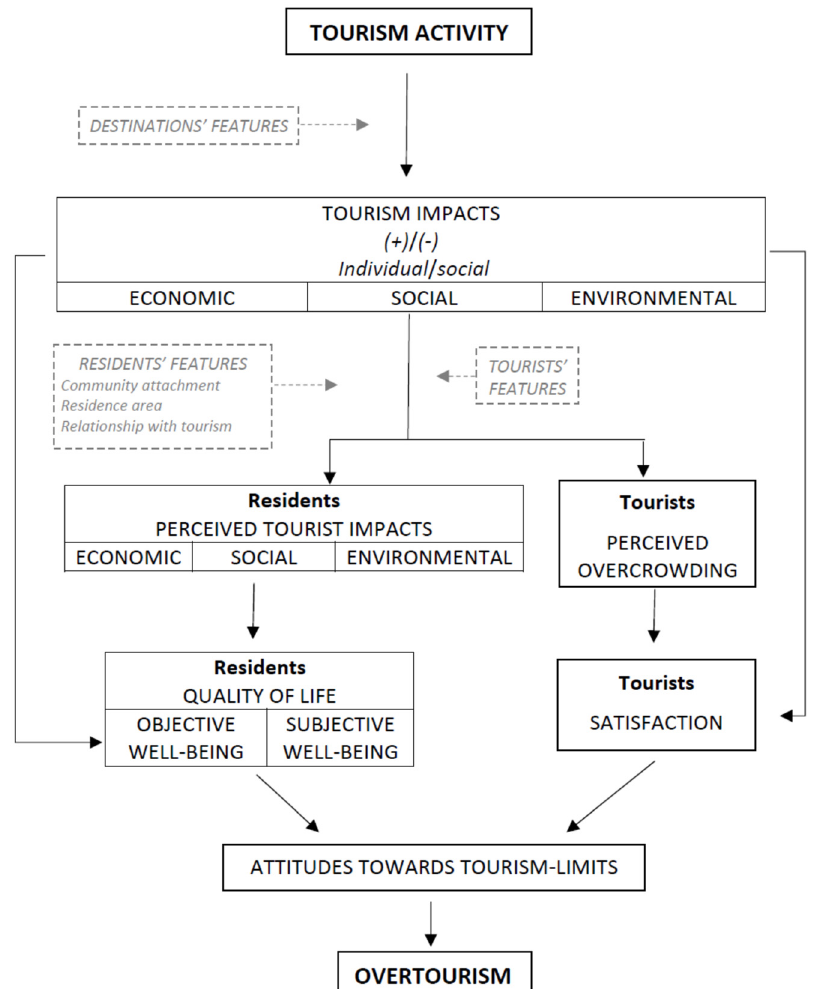
Figure 5. Measuring overtourism: perceived impacts and attitude towards the future of the sector.